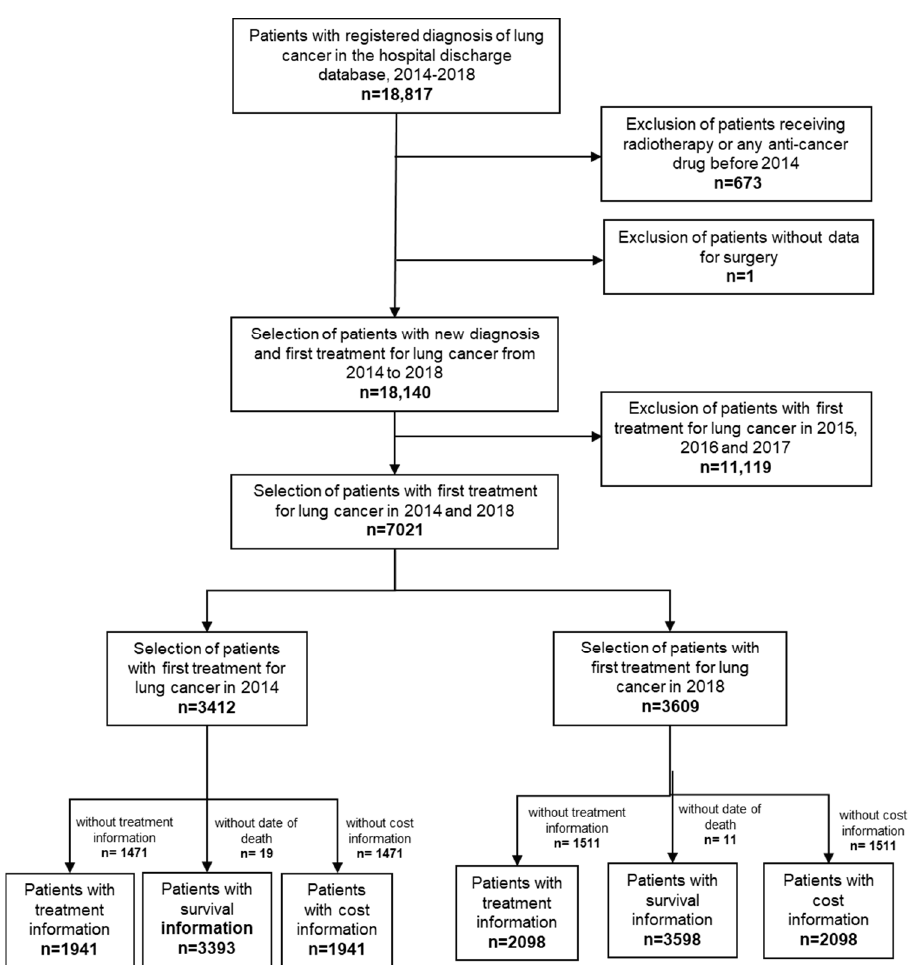
Figure 1. Flow diagram of lung cancer patients included in the study. Table 1. Characteristics of patients diagnosed with malignant neoplasm of the lung, 2014 versus 2018.